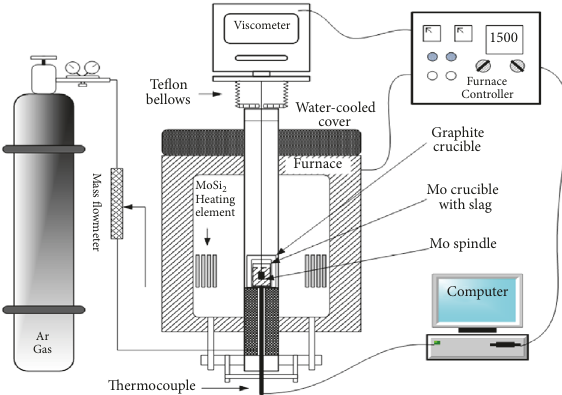
Figure 1: Experimental setup for viscosity measurements.